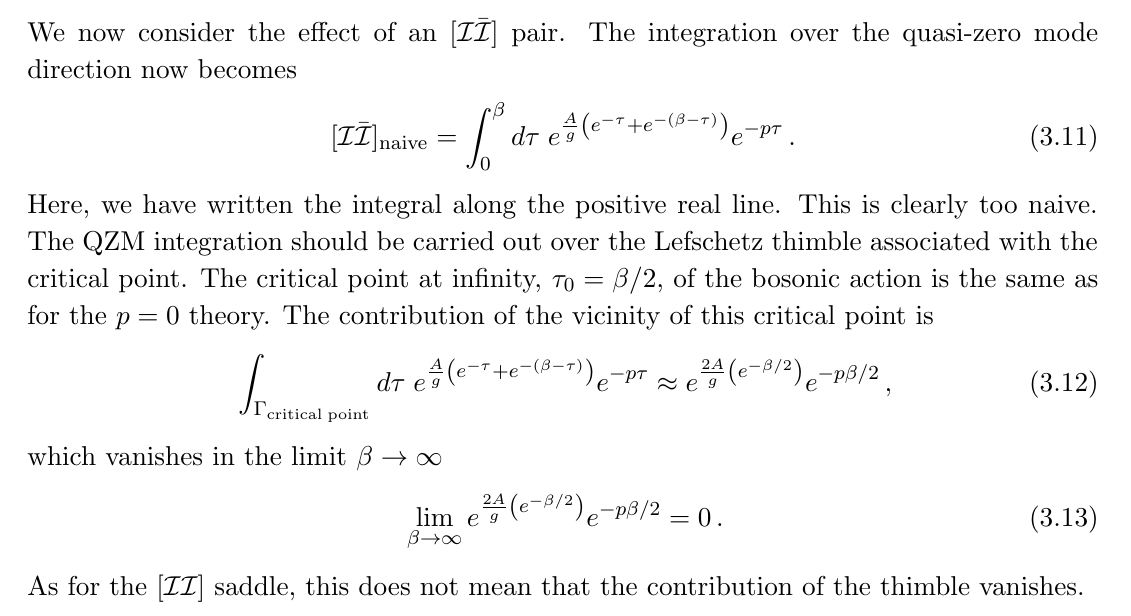
Figure 2 . The e(cid:11)ective interaction potential V (cid:16) (cid:17) A critical value (cid:28) = ln gives the dominant contribution to the [ II ] amplitude integral in (3.8). (cid:3) g p (cid:16) (cid:17) A . See (cid:12)gure 2 for a sketch of the form of the [ II ] interaction potential. (cid:28) (cid:3) = ln g p